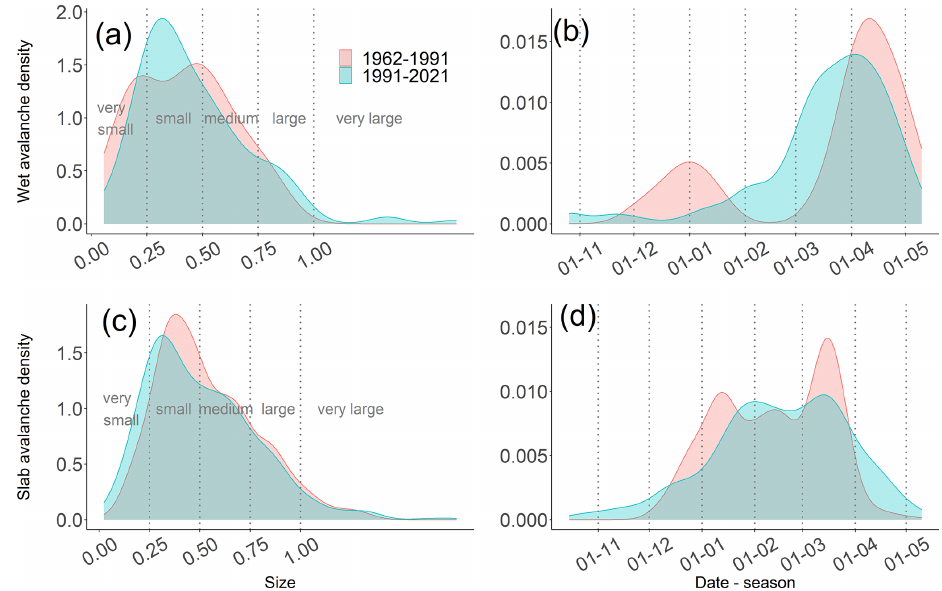
Figure 3. Wet-snow and slab-avalanche characteristics split into two winter season periods, 1962–1991 and 1991–2021. (a) Proportional sizes of avalanche length related to the RAMMS 100-year return period output. (b) Winter season distribution of avalanche